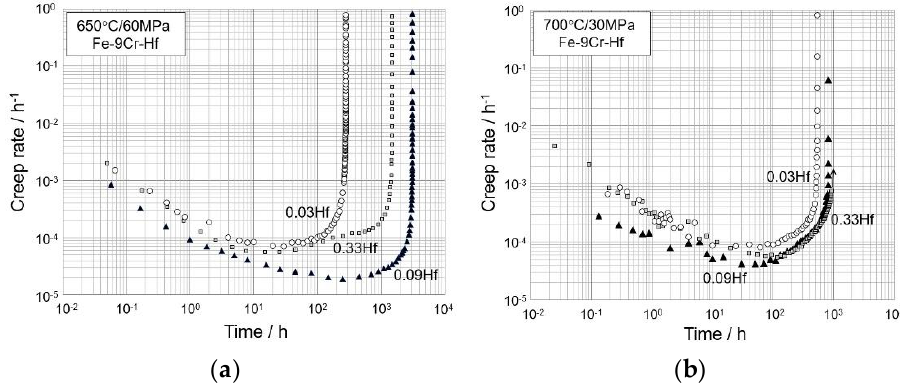
Figure 5. Creep rate vs. time curves in a logarithmic time scale for the creep tests shown in Figure 3: